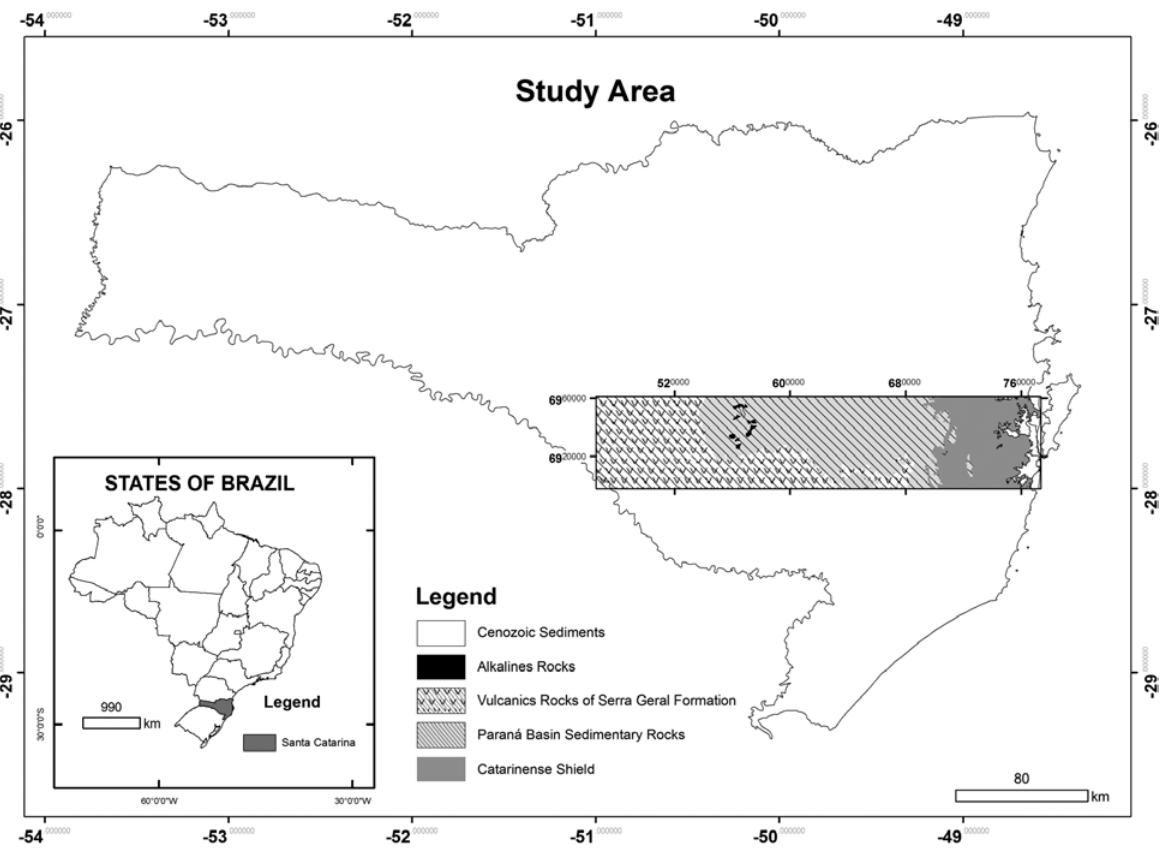
Figure 1 - Study area located in the Santa Catarina State, Brazil.Paraná